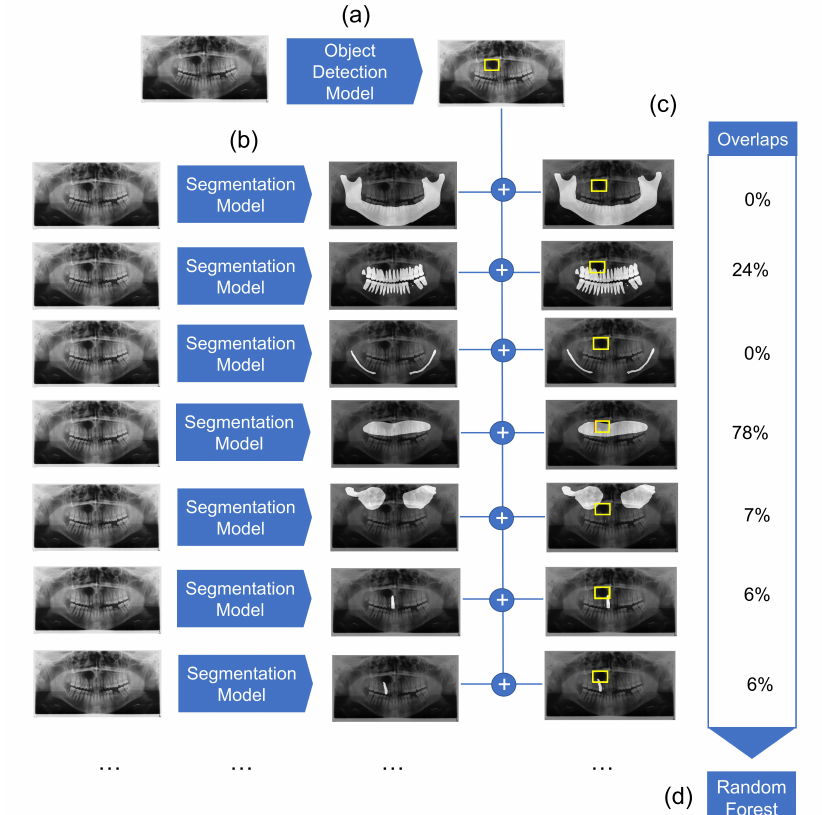
Figure 1. Overview of the diagnostic pipeline. ( a ) First, the object detection model detects cystic lesions and marks them with a bounding box. ( b ) Next, multiple segmentation models are employed which segment structures of maxilla, mandible, mandibular canal, maxillary sinuses, the complete dentition, as well as each individual tooth. ( c ) The overlaps between the marked bounding box and segmented structures are then calculated. ( d ) Finally, the Random Forest classifier gives a preliminary diagnosis based on the computed overlaps for each